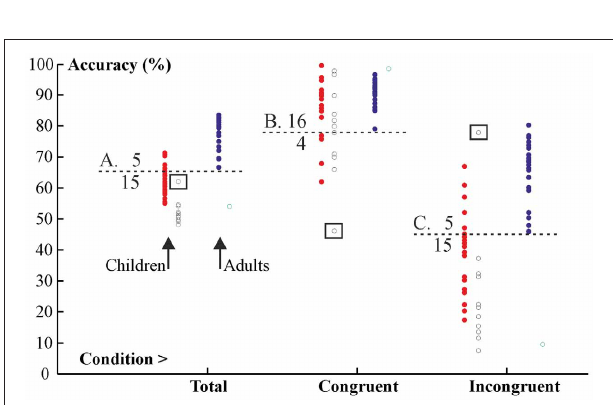
FIGURE 5 | Individual variability in performance. Filled circles show participants included in analyses. Open circles show participants excluded from analyses. Children’s data are on the left and adults’ data are on the right. One excluded child participant with atypical data is marked by